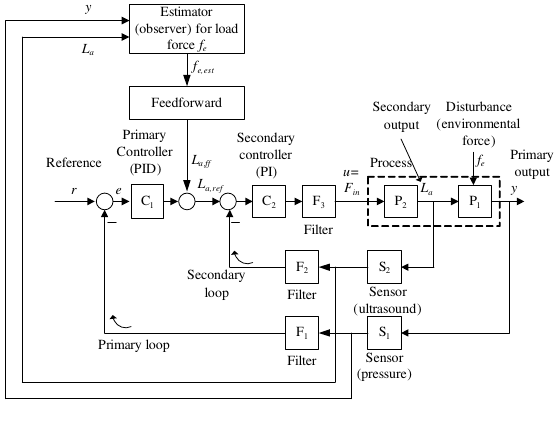
Figure 6: The structure of the cascade control system including estimator (observer) and feedfor- ward